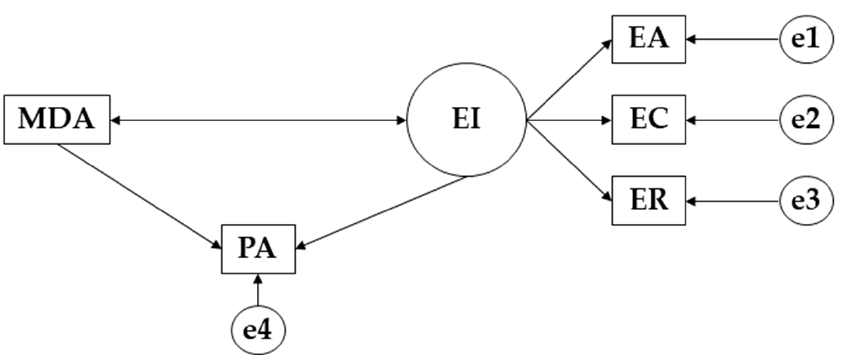
Figure 1. Structural equation model. Note: Emotional Clarity (EC); Emotional attention (EA); Emotional Repair (ER); Mediterranean diet adherence (MDA); Physical activity (PA).